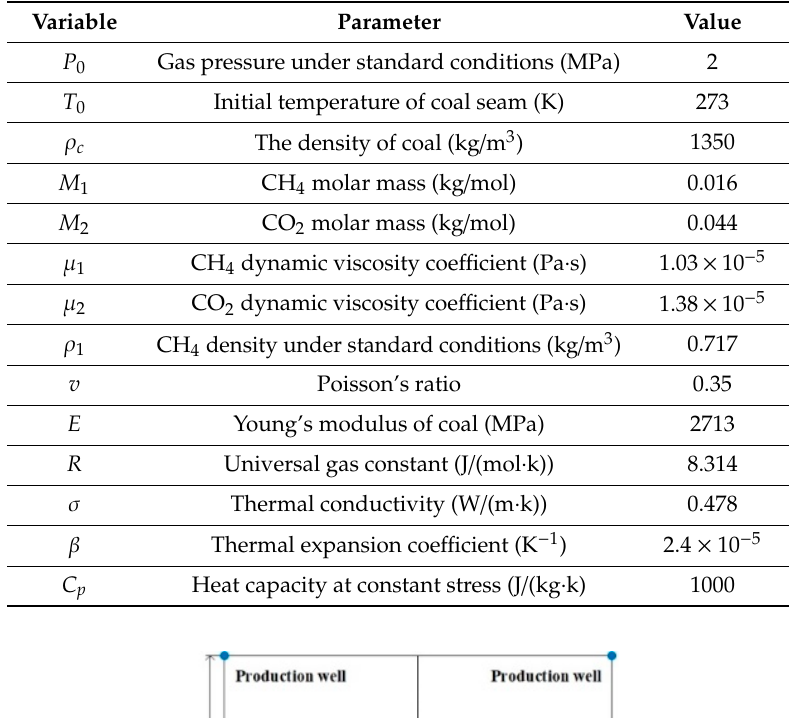
Table 1. Numerical simulation parameter